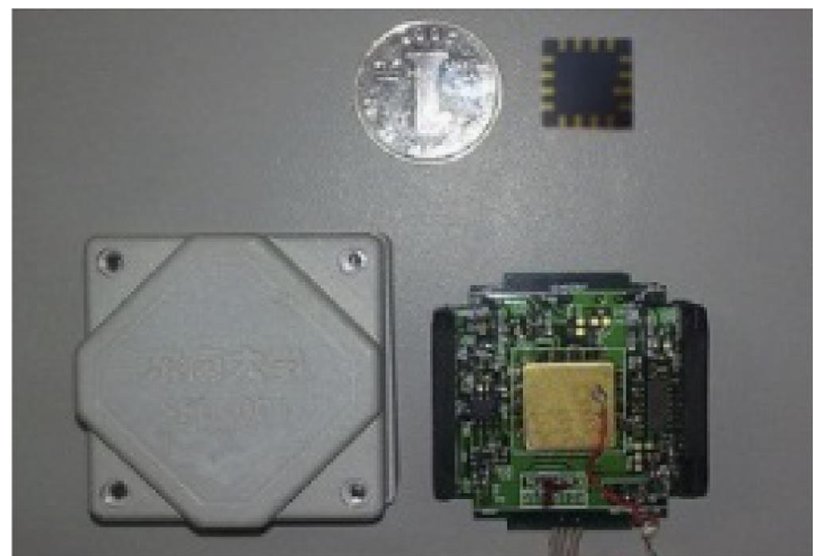
Figure 9. The PCB and gyroscope overall photos.